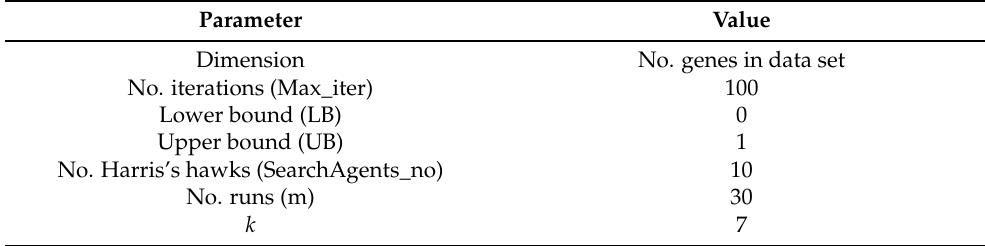
Table 2. Parameter settings for HHO-SVM and